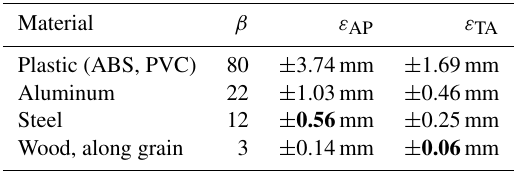
Table 2. Estimated maximum error resulting from thermal expan- sion of anchor pipe ε AP (mm) and tilt arm ε TA (mm) for com- mon materials, together with typical values of the coefficient of lin- ear thermal expansion β (10 − 6 m(mK) − 1 ). Materials used in this study are shown in bold font; note that the short double-pivot seg- ment is made from steel.